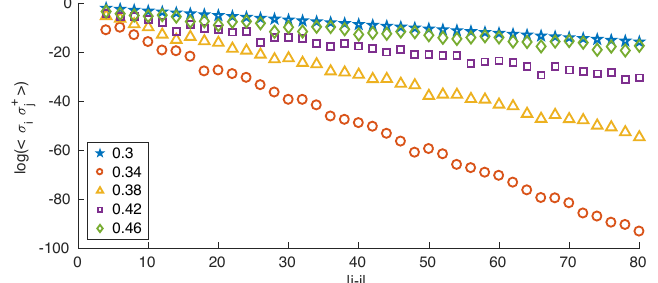
Figure 6: The log of the spin-spin correlator in the ground state in the gapped phase = 1 and various λ at λ values given in the legend. The correlator was obtained P 1 using DMRG with L = 300 and a maximum bond dimension of 400. The incommen- surability is readily apparent in the oscillations present for λ